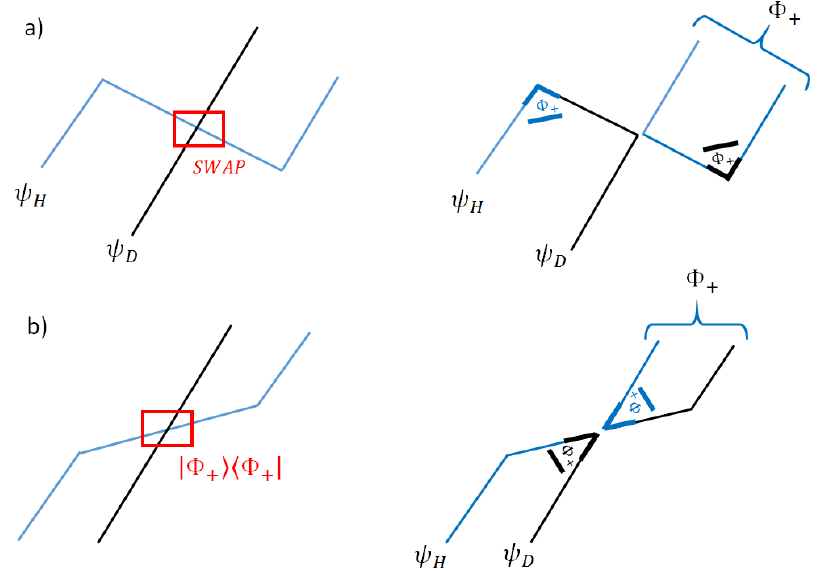
Figure 12 . The swap in the post-selected world destroys information: it maps arbitrary states to (cid:12)nal state (cid:30) +